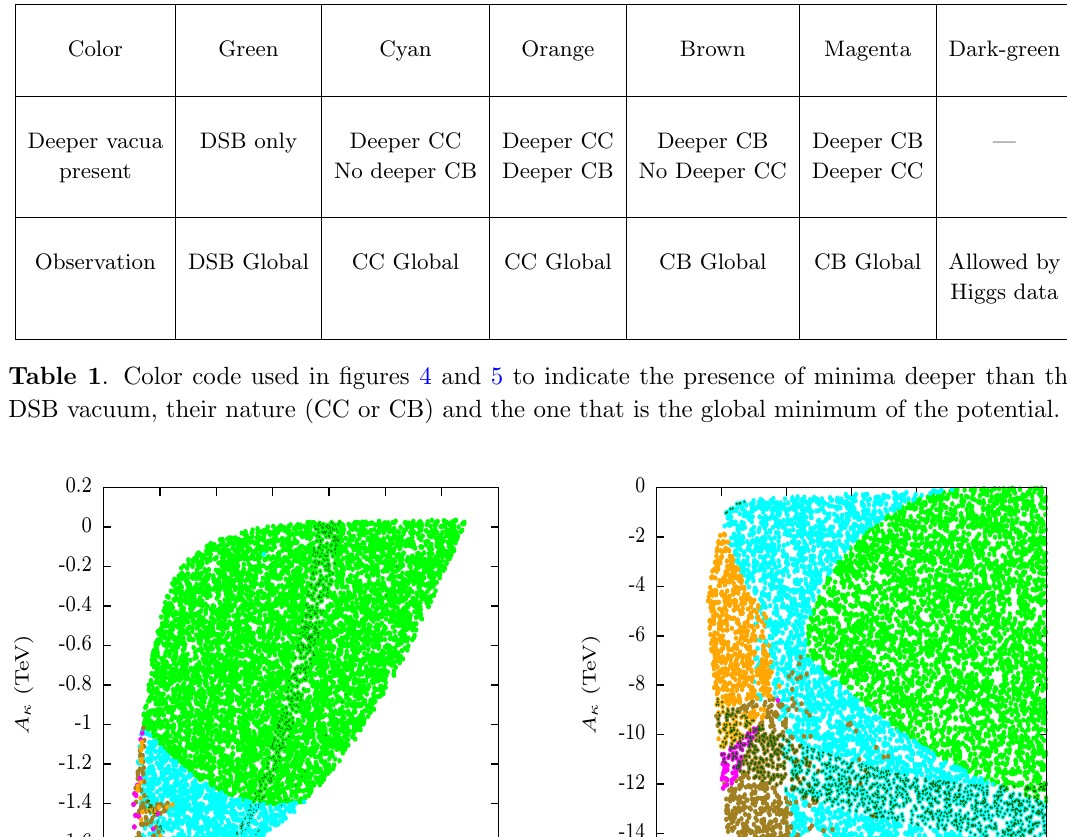
= m = 3 TeV, A t = 1 e Q 3 e U 3